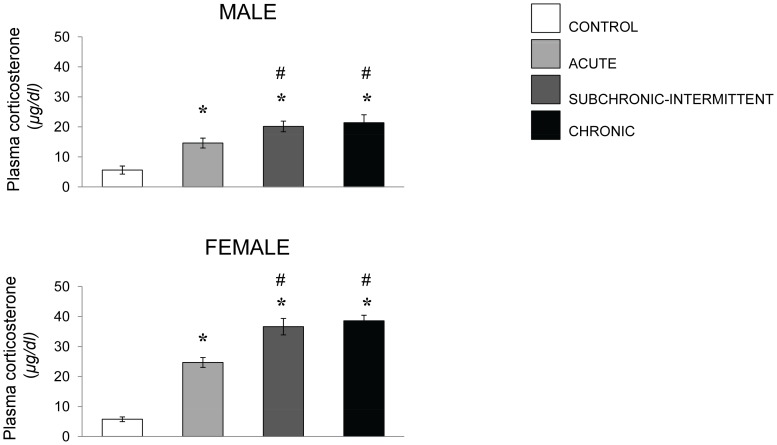
Corticosterone levels following an acute stressor.Mean (± SEM) plasma corticosterone concentrations (µg/dl) among male (upper) and female (lower) mice that had experienced either no stress, restraint for 15 min, or a resident-intruder stressor. *p<.05 relative to nonstressed mice of the same sex. # p<.05 relative to acutely stressed mice.